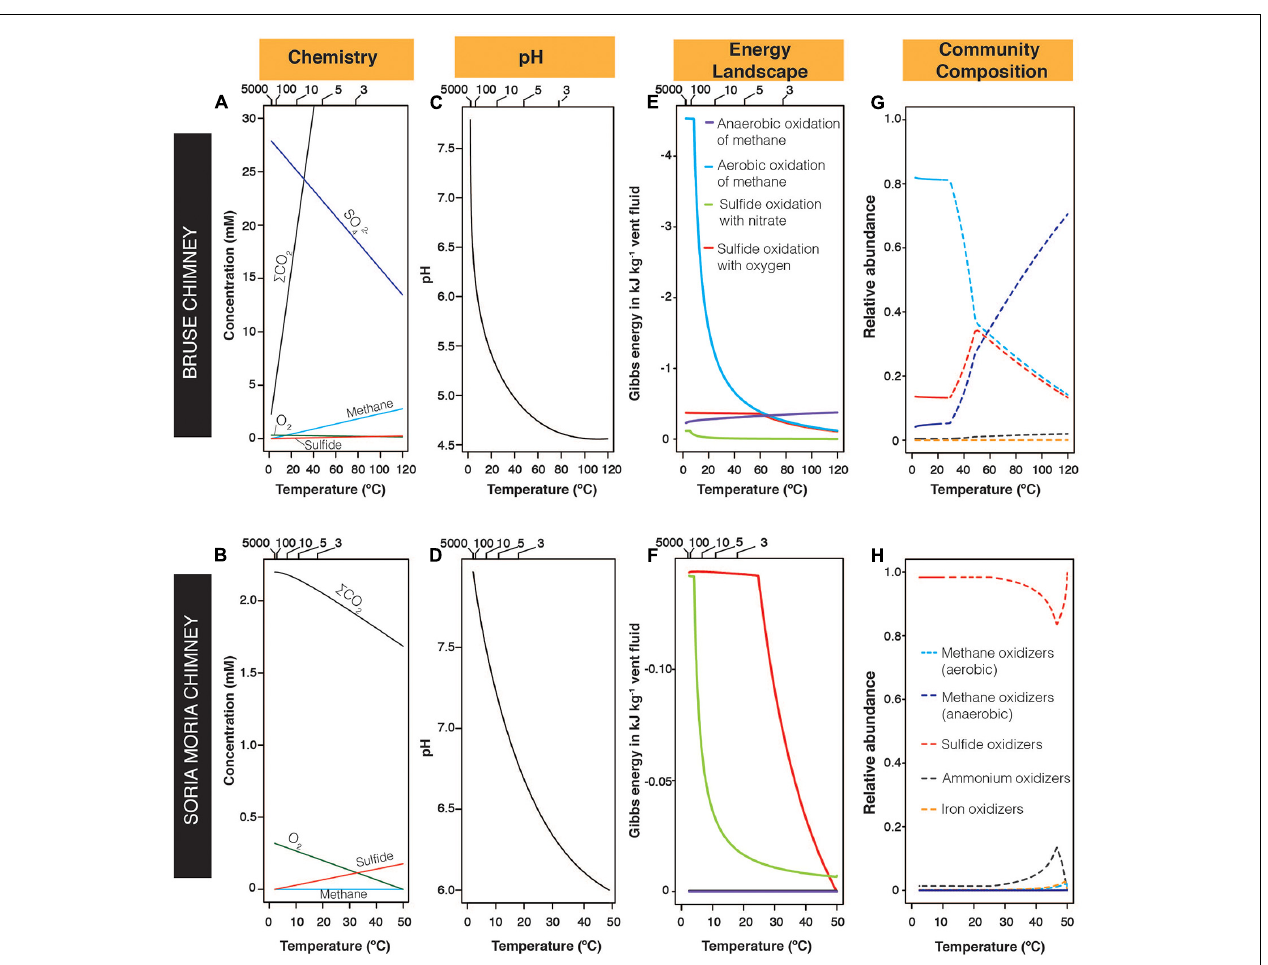
FIGURE 2 | Modeled chemical gradients, energy landscapes, and microbial communities in the Bruse chimney and the Soria Moria chimney at different temperatures. (A,B) Modeled concentrations of selected chemical species. Sulfate concentrations in the Soria Moria chimney are not shown, but were in the range of 27–28 mM. (C,D) Modeled changes in pH across the two chimneys. (E,F) Modeled energy landscapes based on reactions given in Table 2 . For clarity, graphs are not shown for reactions where Gibbs energies are close to 0 for all temperatures considered in both chimneys. (G,H) Modeled relative abundances of functional groups defined in Table 2 . For clarity, graphs are not shown for functional groups with relative abundances < 1% for all considered temperatures in both chimneys. Upper horizontal axes in (A–F) indicate seawater:hydrothermal-fluid mixing ratios. Legends in (E) also apply for (F) , legends in (G) also apply for (H)